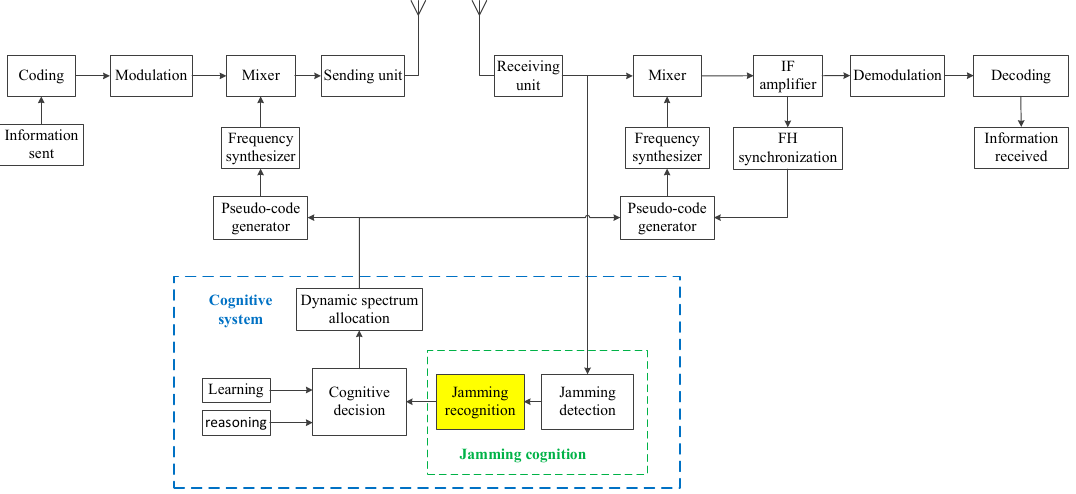
Figure 1. Block diagram of the unmanned aircraft vehicle frequency hopping (UAV FH) system.